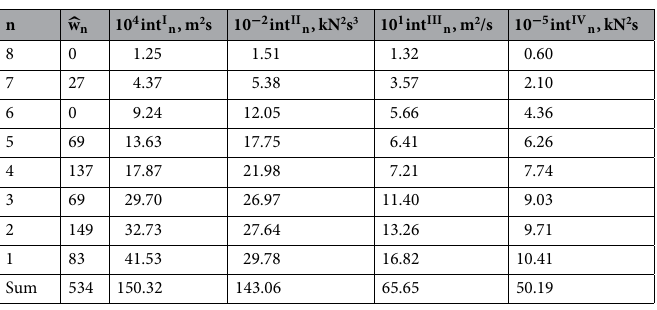
9 I 3 I 6 I , Q 2 = 10 , Q 3 = 10 , Q 4 =